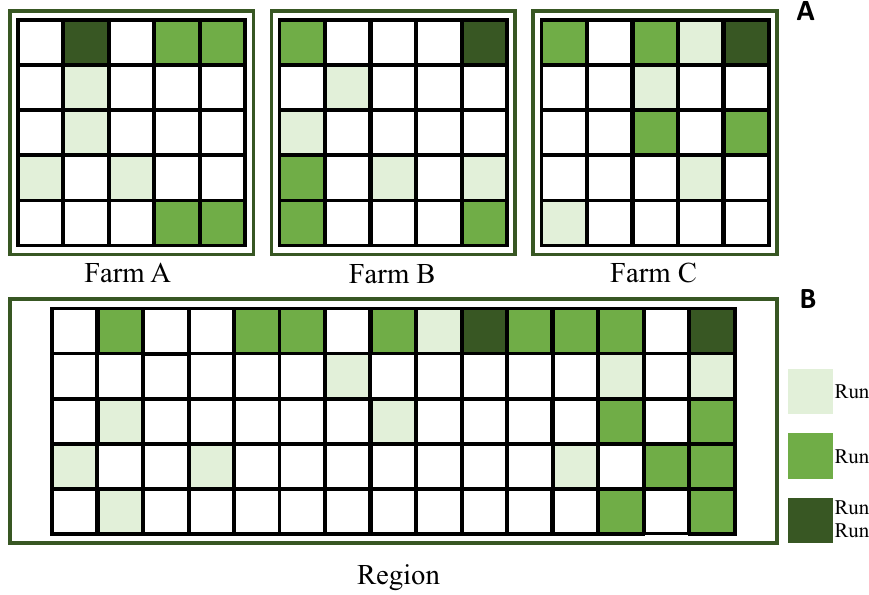
Figure 4. Schematic illustration of the random allocation of grassland types on different policy target levels. A given share of extensive grassland (here 20%) is randomly distributed ( A ) within each farm; ( B ) on regional scale. Green and light green cells represent two possible outputs of repeated runs. Dark green cells imply that the corresponding parcel had been randomly selected in both simulation runs. The white parcels represent all other agricultural land uses (intensive grassland and crop production). Please note that for illustrative purpose, parcels are represented as squares here. In our data, the effective size and shape of the parcels is